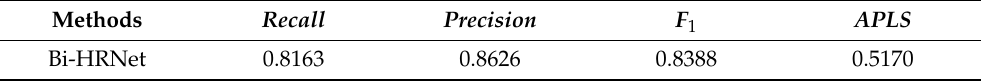
Table 5. Quantitative results of the proposed method on the constructed Massachusetts dataset.